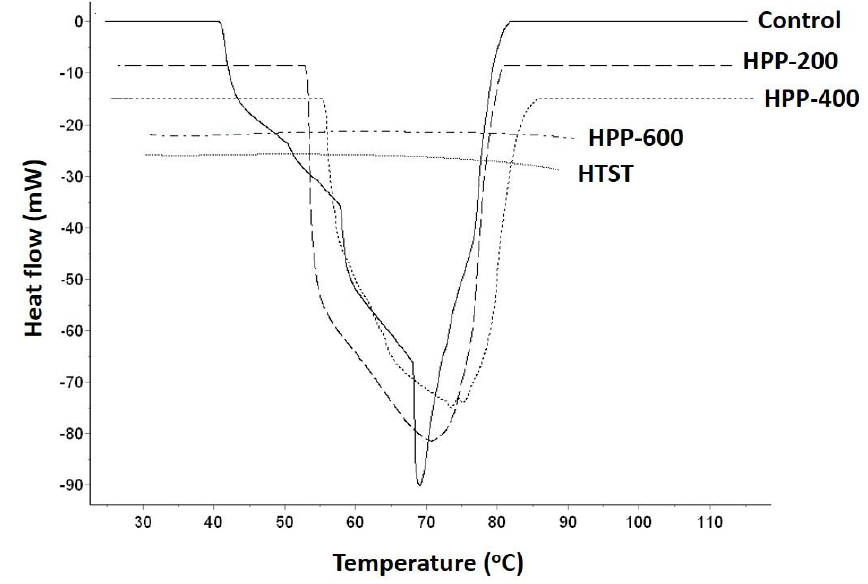
Figure 2. DSC thermograms of control, HTST, and HPP treated pigeon pea milk starch granules.